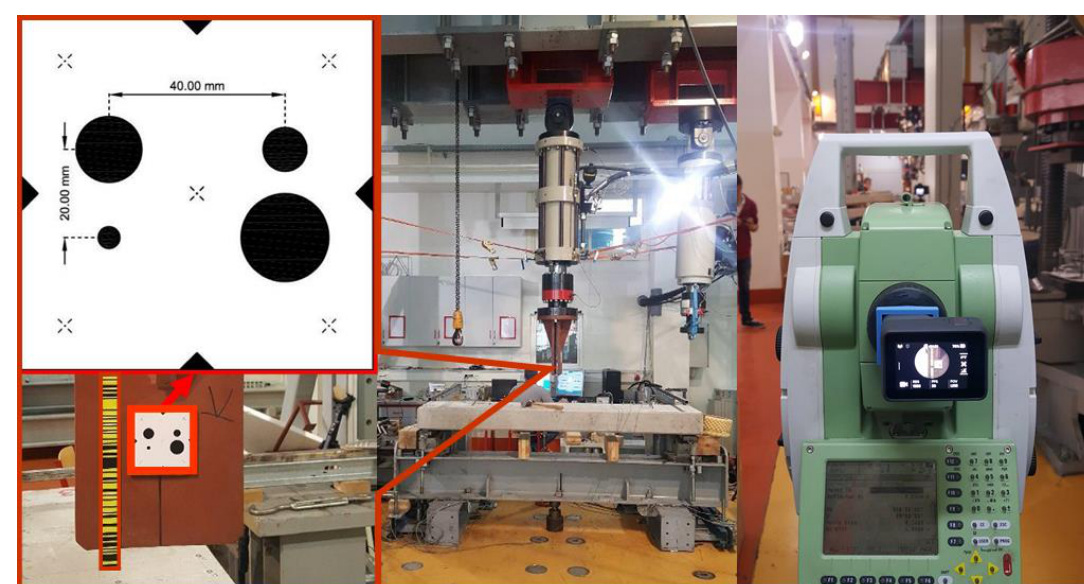
Figure 4. Photomark measuring signal (red on the left ), testing machine ( middle ), and IATS prototype ( right ) setup in the laboratory for the purpose of measuring simulated dynamic vertical displacements with different amplitudes at 5.0 Hz frequency using multi-purpose universal testing machine.